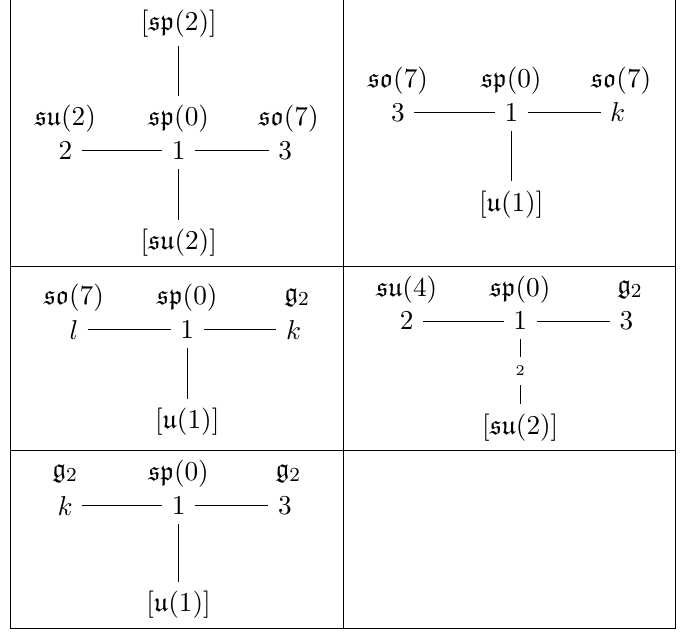
Table 6 . Possible localized flavor symmetries for nodes with a trivial gauge algebra continued from table